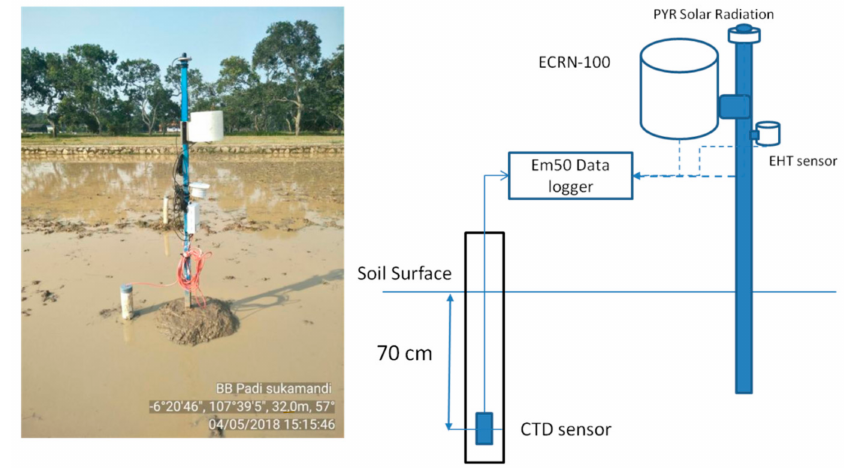
Figure 3. Field measurements of weather and water level